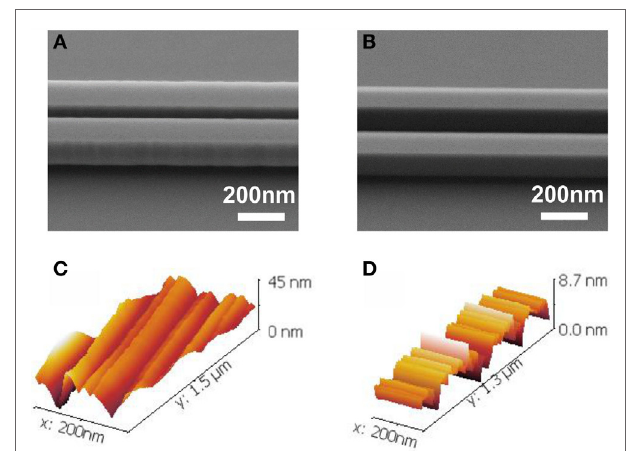
FigUre 3 | seM images of a waveguide (a) on the dry etched only sample (sample a) and (B) on the TMah-treated sample (sample B), imaged at an angle of 45°; (c) aFM image of the side wall of dry etched waveguide with rms roughness of 6.7 nm; (D) aFM image of the side wall of wet etched waveguide with rms roughness of 1.4 nm .